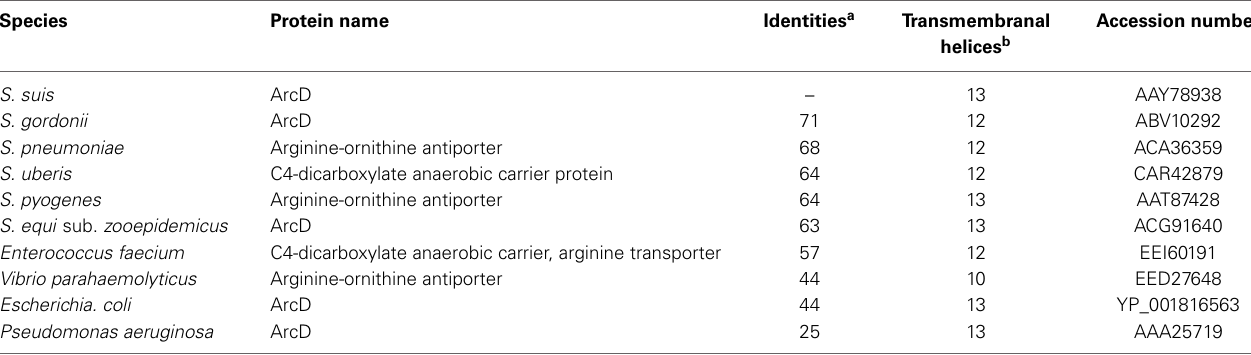
Table 1 | Comparison of putative arginine-ornithine transporters of different bacterial species. Species Protein name Identities a